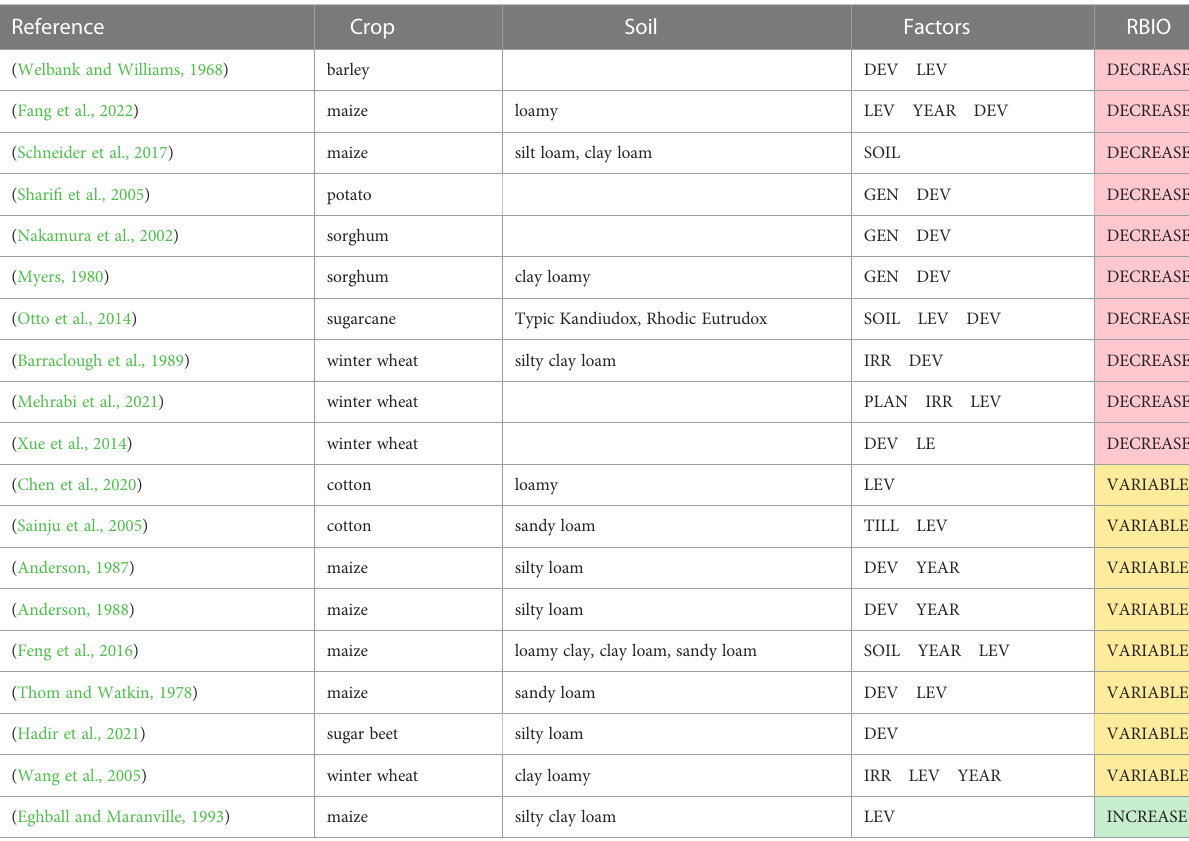
TABLE 3 Studies that report effects of N de fi ciency on root biomass (RBIO) at fi eld scale.